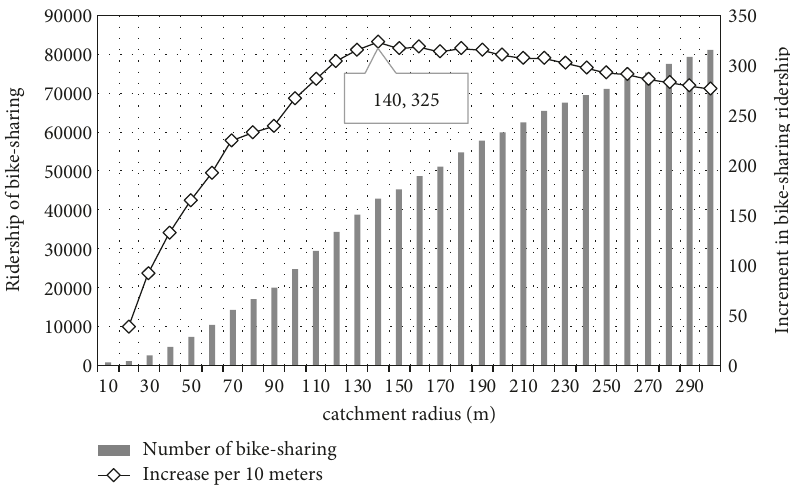
Figure 3: Screening test of the catchment method with varying